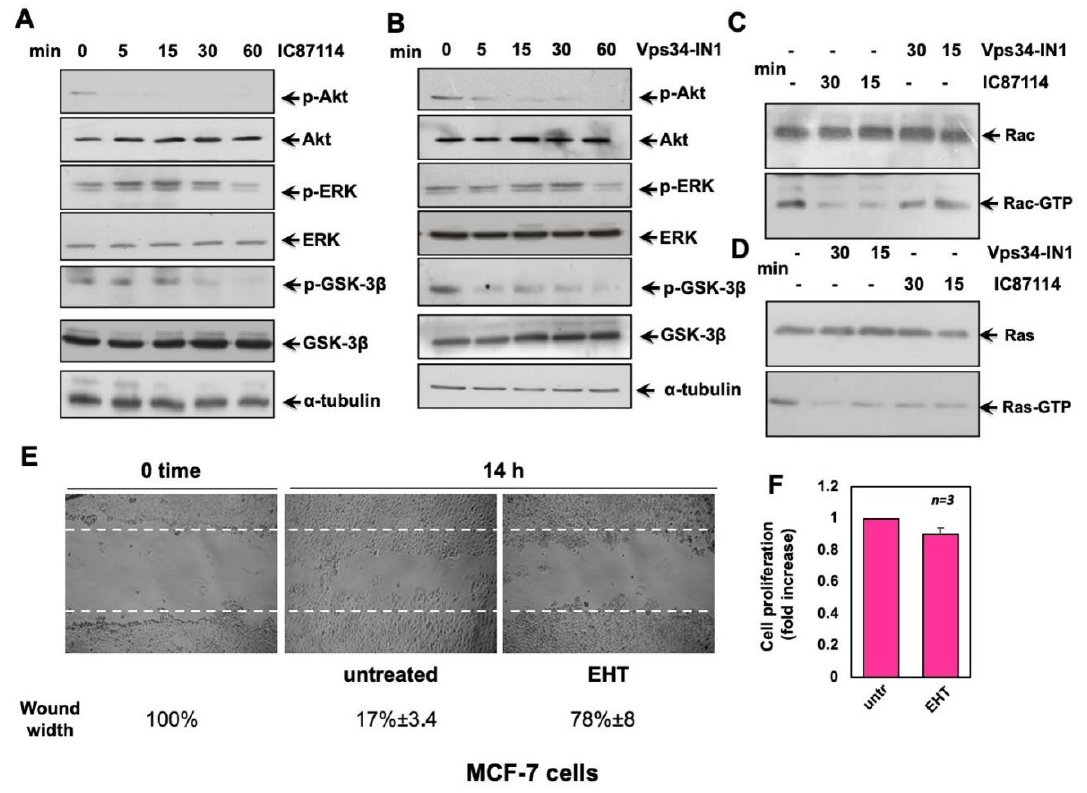
Figure 5. Effects of IC87114 and Vsp34-IN1 on MCF-7 cell signalling pathways. MCF-7 cells were untreated or treated for the indicated times with IC87114 ( A ) or Vsp34-IN1 ( B ), and cell lysates were analysed by western blot, using antibodies against p-Akt (p-Ser-473 Akt), p-ERK (P-Tyr 204 ERK 1 and the corresponding phosphorylated ERK 2), and p-GSK-3 β (p-Ser-9 GSK-3 β ). The blots were re-probed using anti-ERK, anti-Akt, anti-GSK-3 β , or anti- α -tubulin antibodies, as loading controls. ( C , D ) MCF-7 cells were untreated or treated with IC87114 and Vsp34-IN1 for 30 and 15 min, and Rac ( C ) and Ras ( D ) pull down assays were performed. Active (Rac-GTP) or total Rac (Rac) in C and active (Ras-GTP) or total Ras in D were detected by western blot. Western blots ( A – D ) are representative of three different experiments. ( E ) Cell monolayers were wounded, and unchallenged or challenged for 14 h with the indicated compounds. Phase-contrast images are representative of three different experiments. The wound area was measured using Image J Software, and data are presented as residual % in wound width over the control (0 time) below the corresponding images. ( F ) Cell proliferation was analysed by WST-1, and data represented as fold change over the basal level (untreated cells). Means and SEM are shown. In ( E , F ), EHT is EHT 1864.